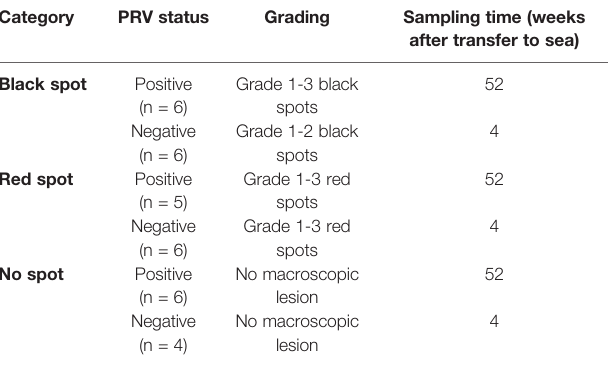
TABLE 1 | Samples selected from red and black